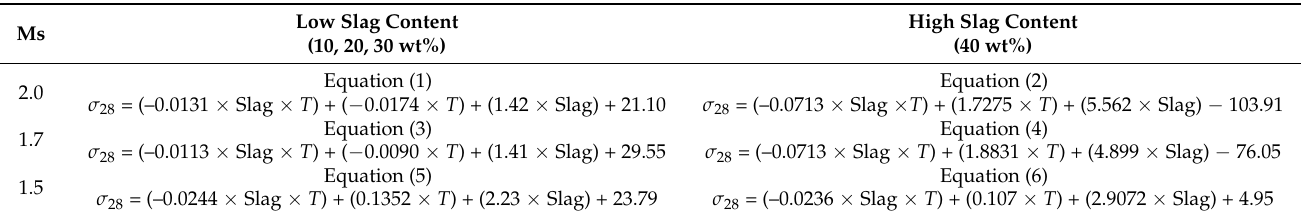
Table 4. Master equations for prediction of 28-day compressive strength ( σ 28 ) as a function of curing temperature and slag content for different Ms